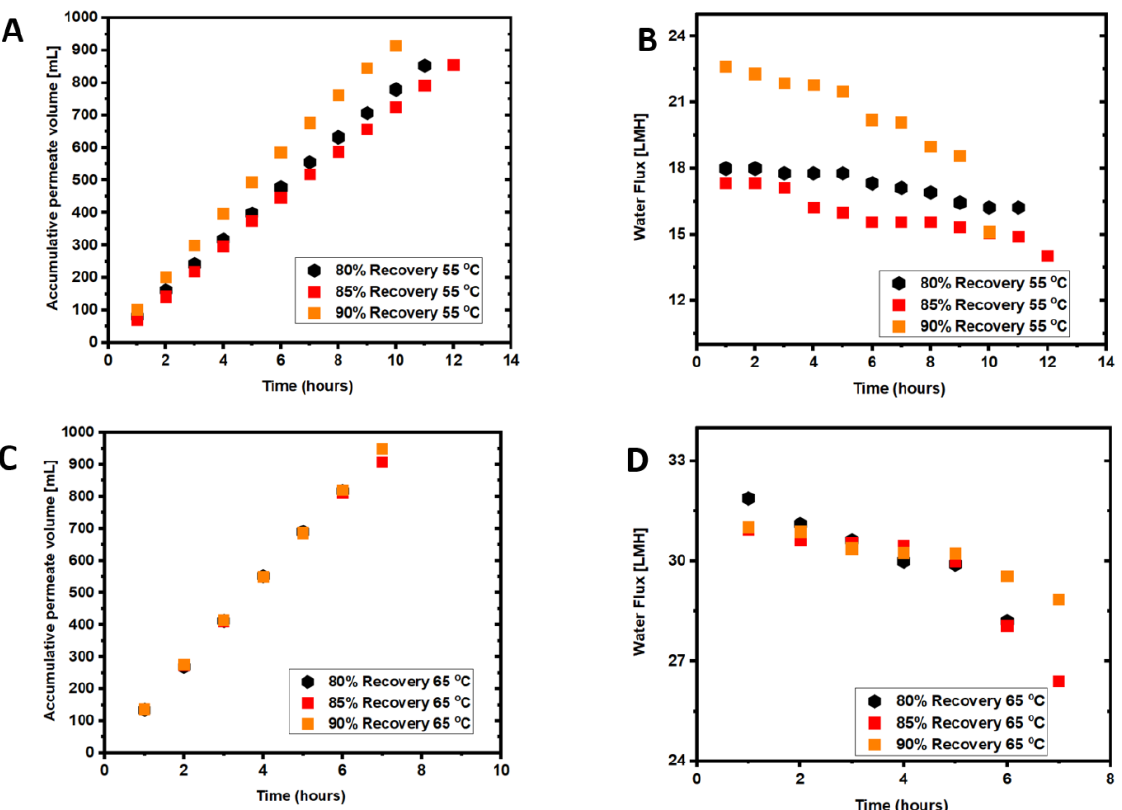
Figure 5. Permeate volume and water flux in AMGD: ( A ) 55 °C accumulative permeate volume; ( B ) 55 °C water flux in the AGMD; ( C ) 65 °C accumulative permeate volume, and ( D ) 65 °C water flux.